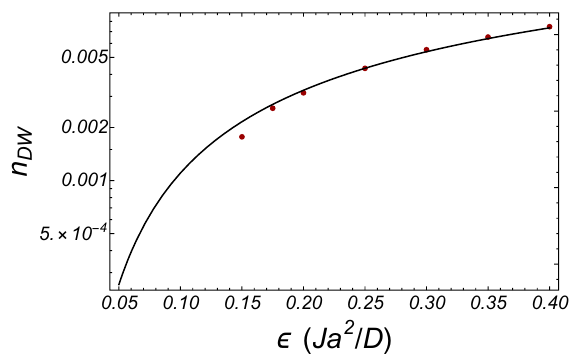
(cid:112) ˜ ε where we obtain for fixed